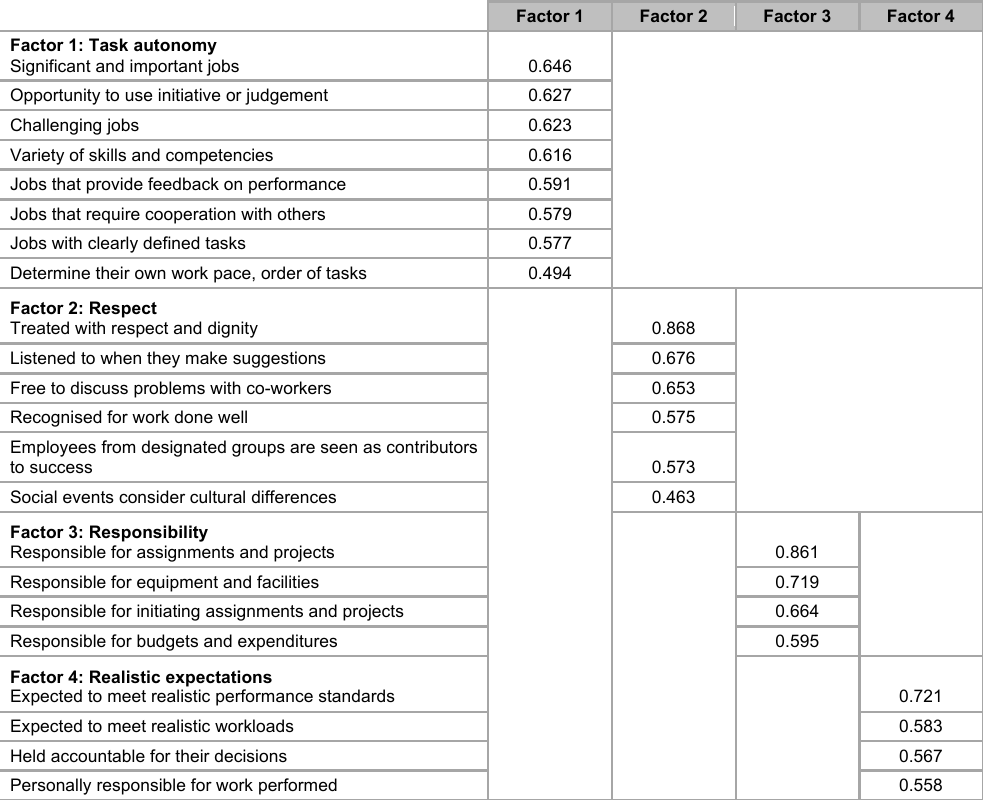
Rotated factor matrix for employee